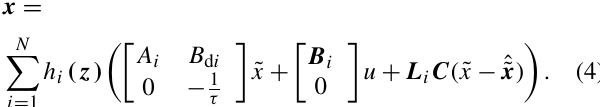
The control scheme is built on a disturbance